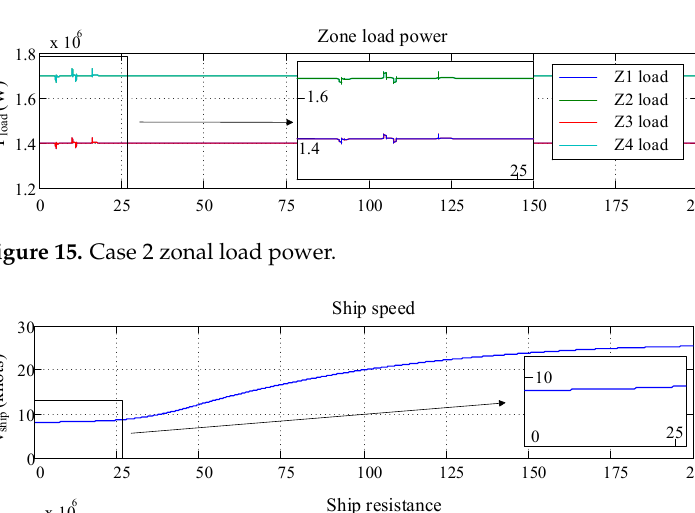
Figure 14. Case 2 PM torque, speed, and power.